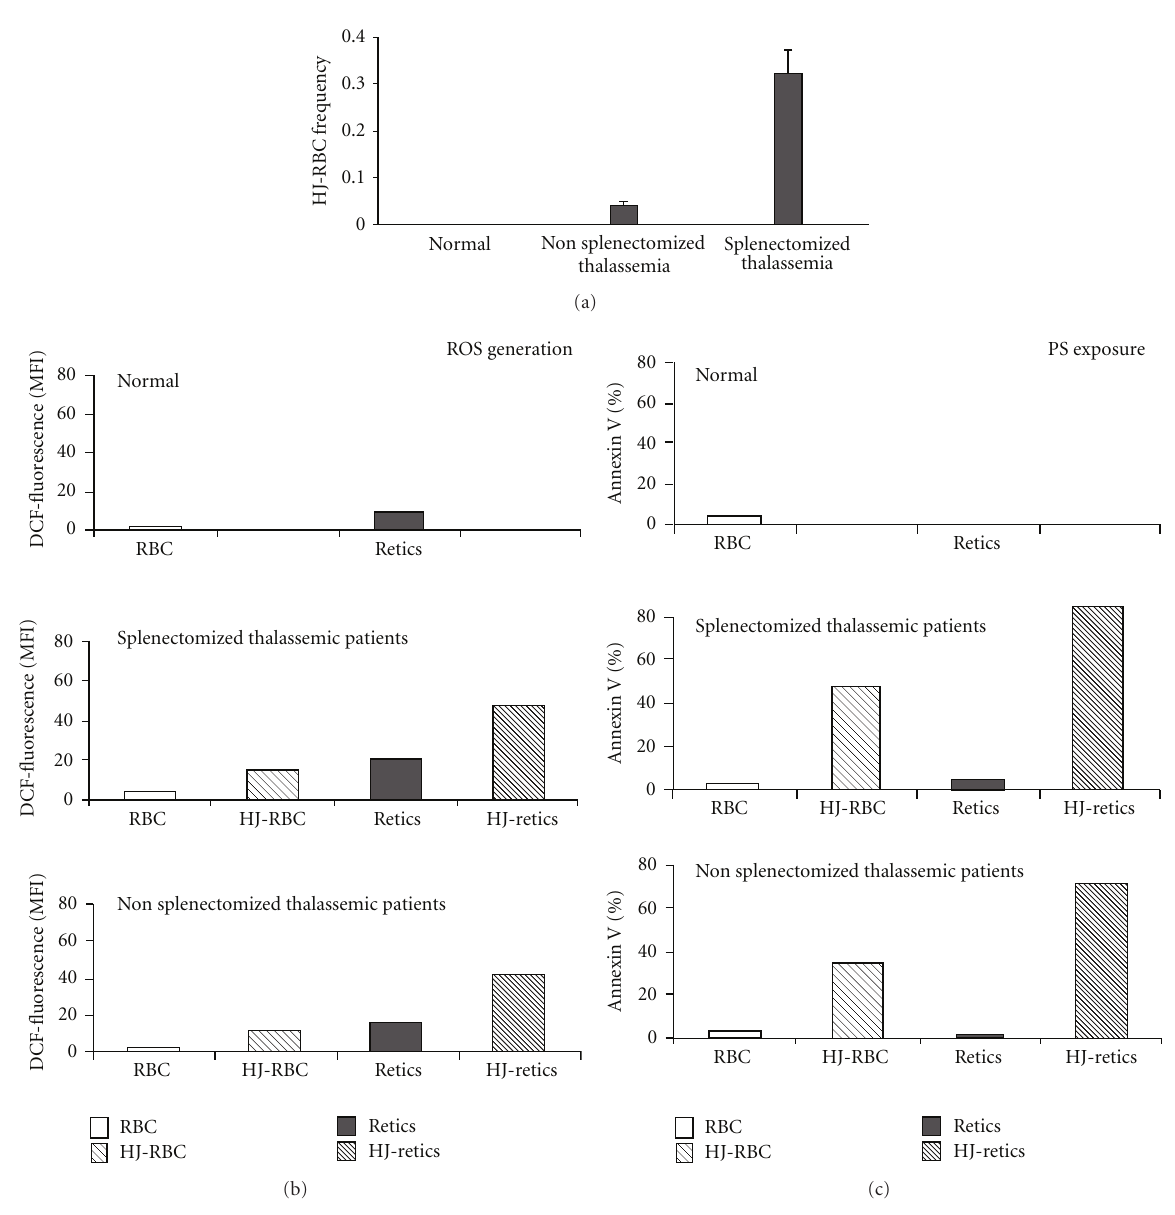
Figure 2: The frequency of HJ-cells and their oxidative status in normal donors and thalassemic patients. Cells obtained from the blood of normal donors and splenectomized and nonsplenectomized thalassemic patients ( N = 6 in each group) were stained and analyzed as in legends to Figure 1(a). (a) The frequency of HJ-RBCs. (b) ROS generation. (c) PS exposure. The results are expressed as the percentage in the RBC population (a), the average ± S.D of the mean DCF-fluorescence index (MFI) for ROS (b) and the percentage of cells positively stained with annexin-V for PS